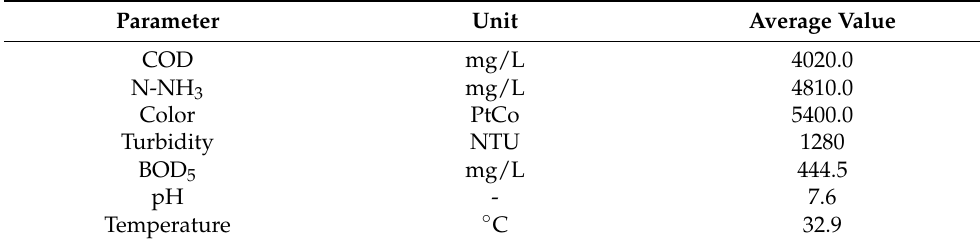
Table 1. Characterization of biologically treated